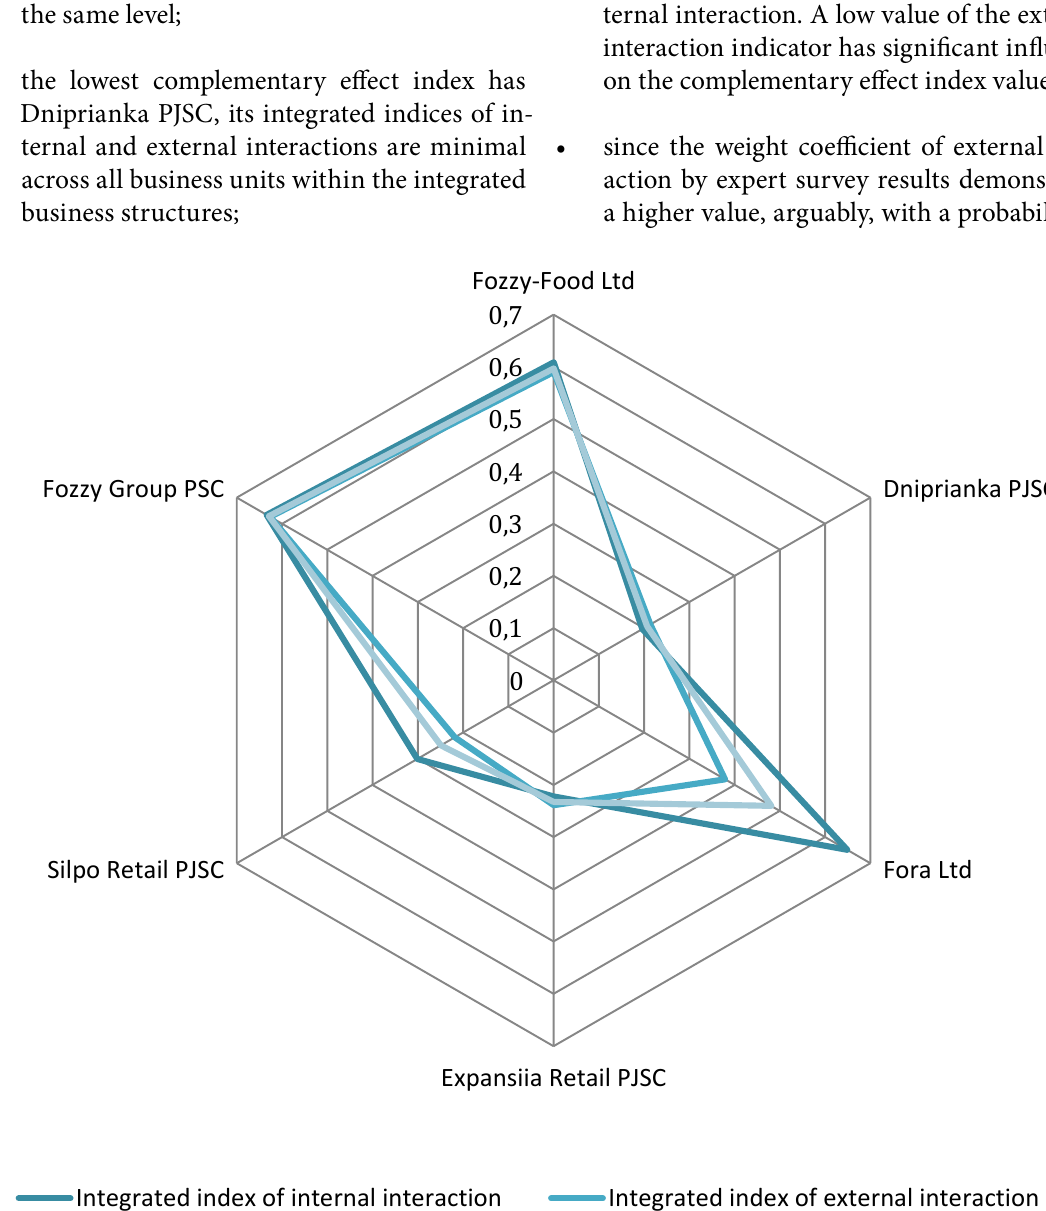
Figure 2. Integrated indices for complementary effect